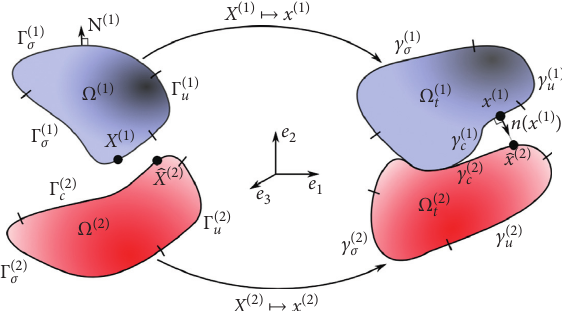
Figure 1: Schematic for two FEM subdomains in contact with outer nodes